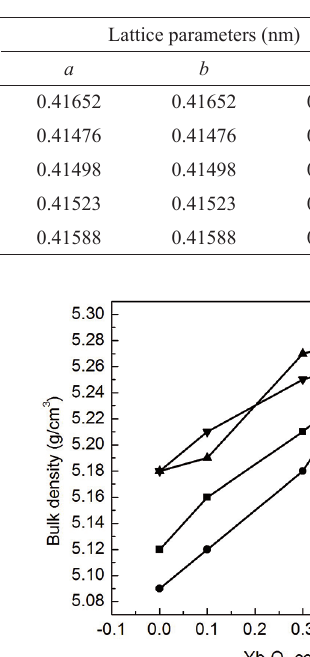
Table 1: The merit for x Yb